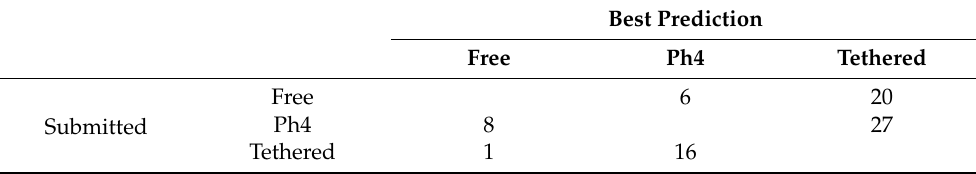
Table 4. Comparison between the submitted docking method vs. the method that yields the best result.